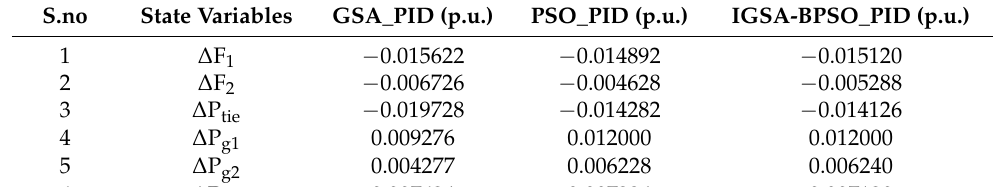
Table 3. Overshoot values(s) for different optimization techniques (O.T.)–PBT.